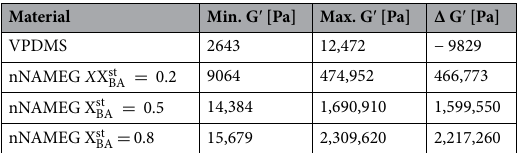
Table 1. Rheological Measurements of NNAMeGs.